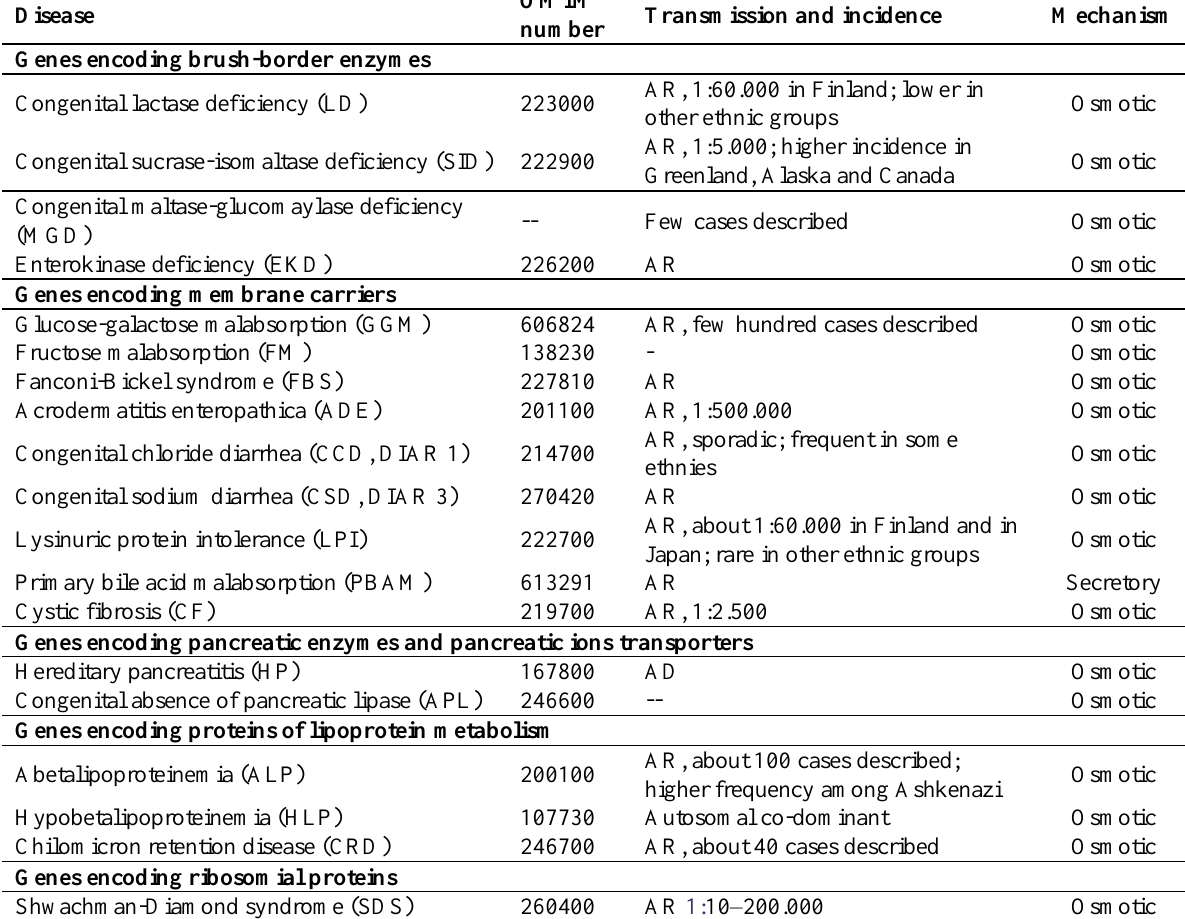
Table 1. Inheritance, epidemiology and main pathological mechanisms of the defects of digestion, absorption and transport of nutrients and